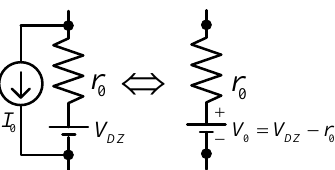
Figure 4. Principal schematic of class-D HB amplifier without control circuitry. An amplifier is powered with unidirectional power supply and augmented with pus-pumping suppression electronics. Capacitors C 1 and C 2 are large enough so that voltages on supply busses can be considered as ripple-free.